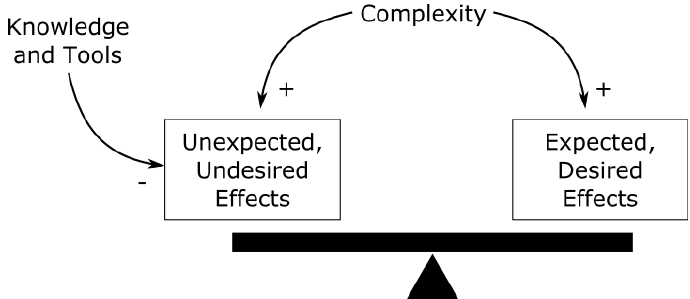
Figure 3. The balance between unexpected, undesired effects and expected, desired effects is influenced both by complexity and by knowledge and